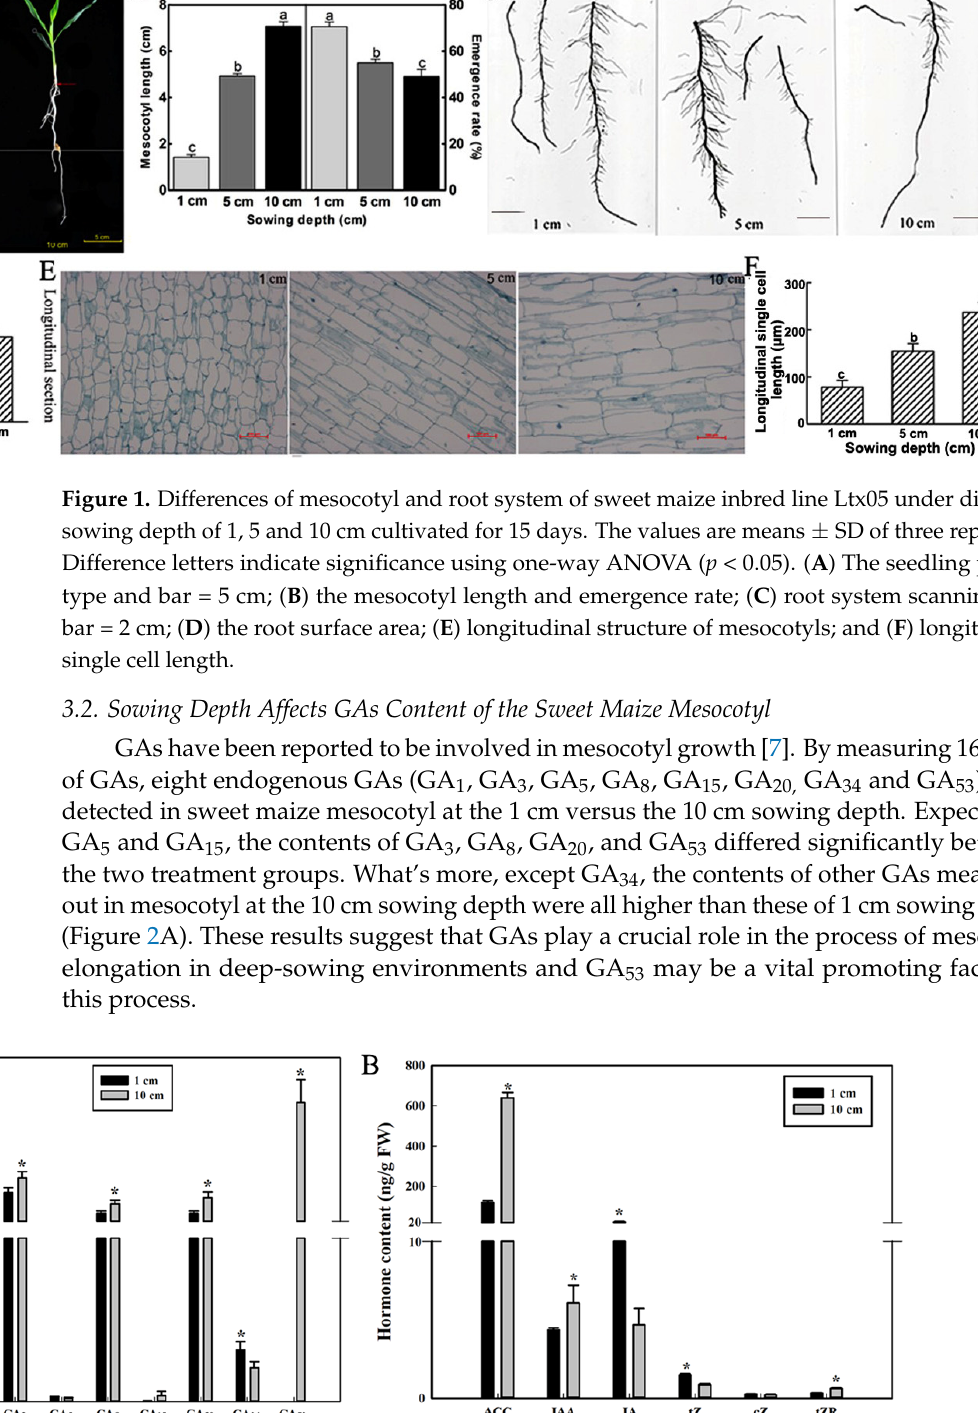
Figure 2. GAs contents ( A ) and other hormone (ethylene precursor, IAA, JA and cytokinin) contents ( B ) of Ltx05 mesocotyls under different sowing depth of 1 and 10 cm cultivated for 15 days. The values are means ± SD of three replicates. Asterisk indicates significant difference between 1 and 10 cm using a Student’s t test (* p < 0.05).